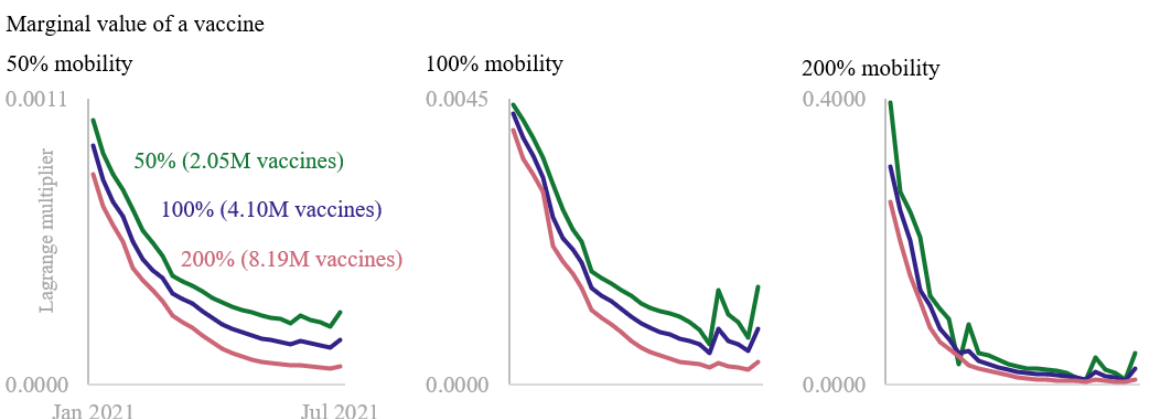
Figure 3. Temporal value of COVID-19 vaccines from January 2021–July 2021 under differing mobility and supply scenarios.